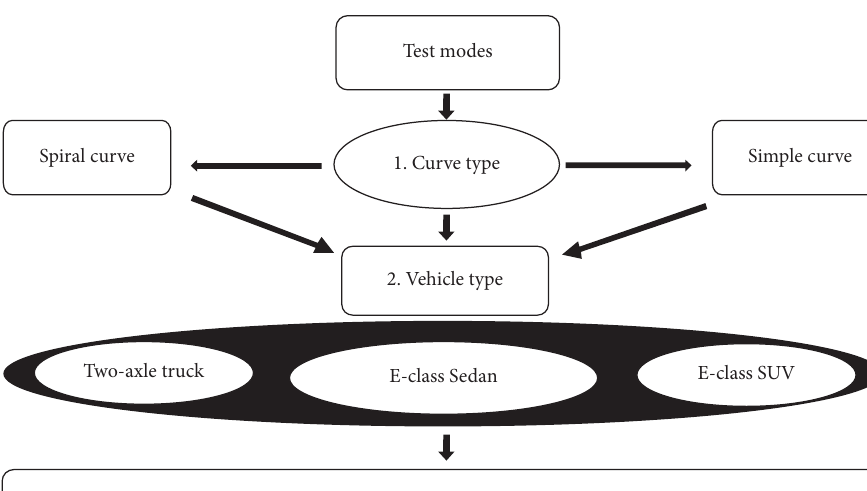
Figure 10: Diagram of the vertical force on the wheels of